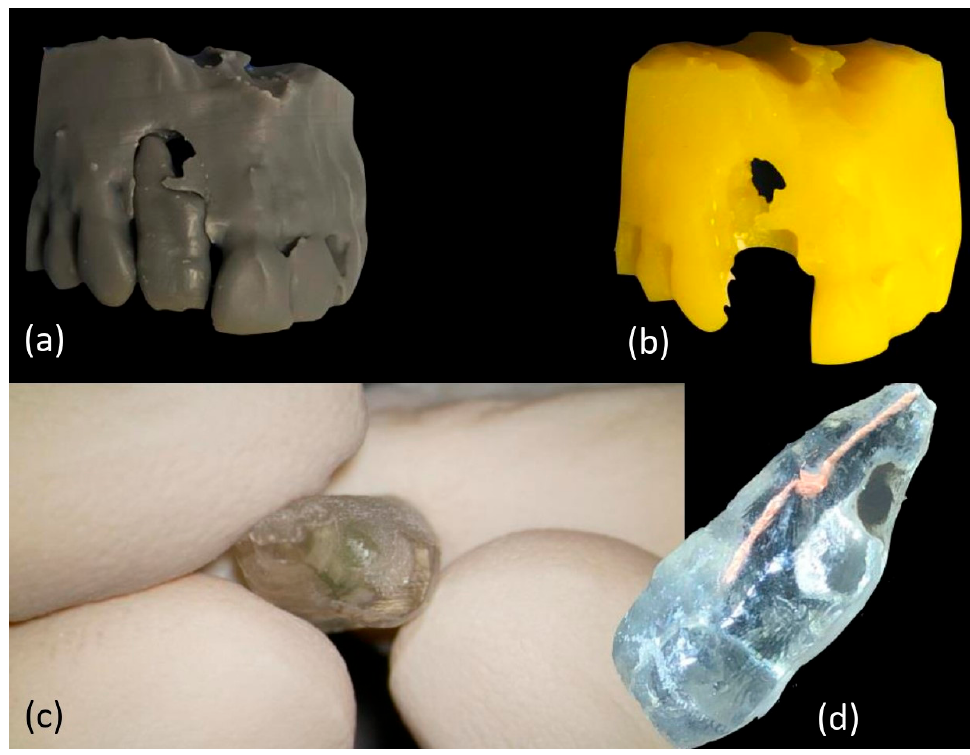
Figure 3. ( a , b ) Customized bone and ( c ) tooth 3D-models were printed. ( d ) Main root canal therapy and invagination retrograde filling were performed on 3D-tooth model.